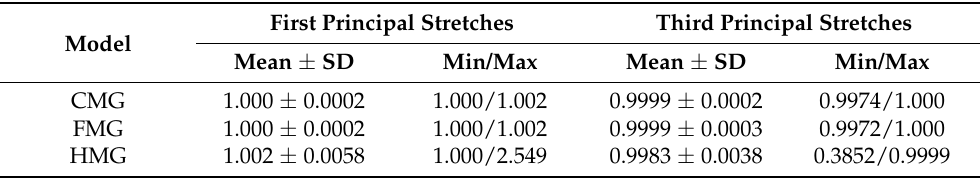
Table 7. Mean and range of stretches over the mouthguard